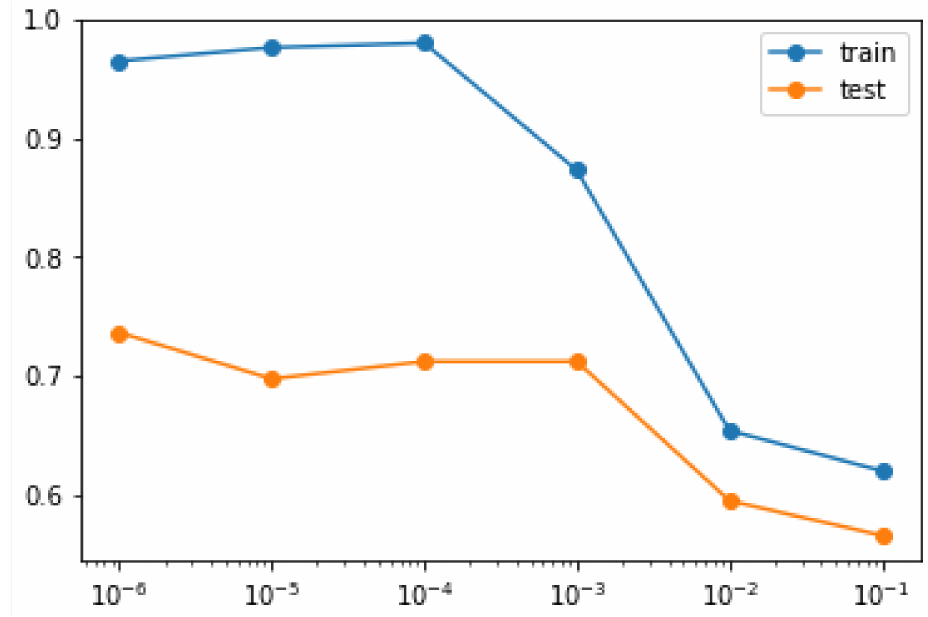
Figure 16. Accuracy plot of the grid search of regularization parameter (VGG-19